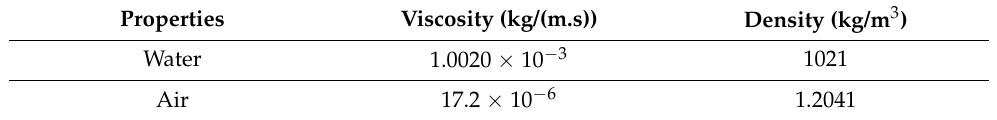
Table 1. Properties of the